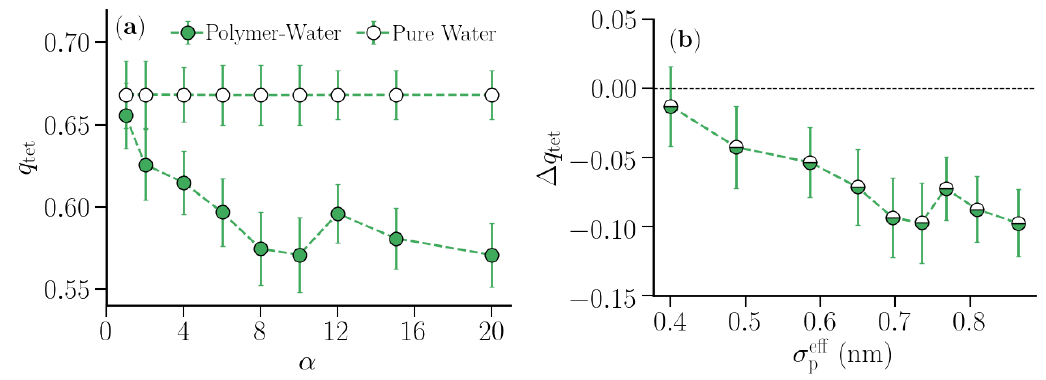
Figure 9. ( a ) Tetrahedral order parameter q tet for the first polymer hydration shell and the corresponding shell in pure water for various strengths α of the repulsive interaction. over four distinct windows in the production trajectory. The lines are guide to the